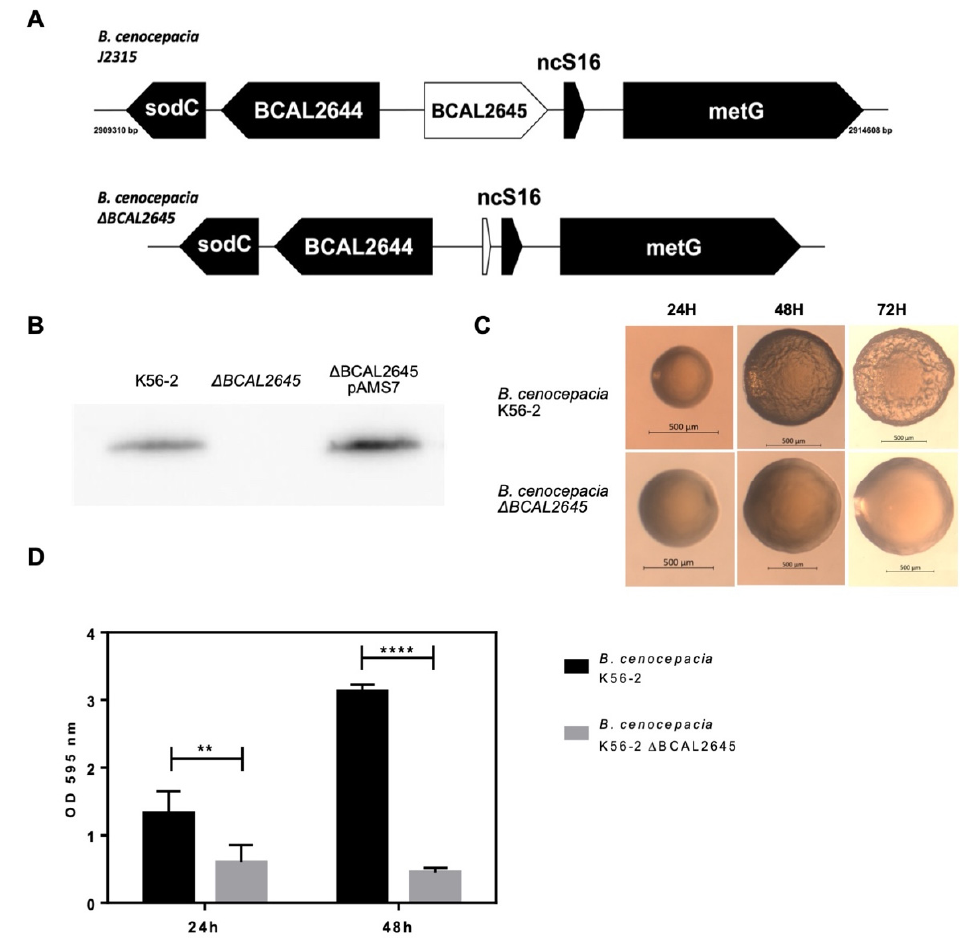
Figure 1. Schematic representation of the region surrounding the BCAL2645 gene, confirmation of the BCAL2645 gene deletion, phenotypic alteration in the bacterial colonies and effects of BCAL2645 gene deletion on B. cenocepacia K56-2 ability to form biofilms ( A ) Representation of the genetic organization of the BCAL2645 gene in the genome of the WT strain and ∆ BCAL2645 deletion strain. ( B ) Western Blot using the anti-BCAL2645 polyclonal antibody against the total protein extracts from B. cenocepacia K56-2, the ∆ BCAL2645 mutant strain and the ∆ BCAL2645 strain complemented with the BCAL2645 gene harbored in plasmid pAMS7. ( C ) Colony morphology change observed in the WT strain where after 48 h a wrinkled colony morphology is observed, while in the ∆ BCAL2645 strain a smooth texture its maintained. Scale bar: 500 µ m. ( D ) Evaluation of biofilm formation by the WT strain and the ∆ BCAL2645 strain in the wells of polystyrene microtiter plates, after 24 or 48 h of growth in LB medium at 37 ◦ C without shaking. Error bars represent the standard deviations of the mean values for three independent experiments. (****, p < 0.0001; **, p < 0.01).